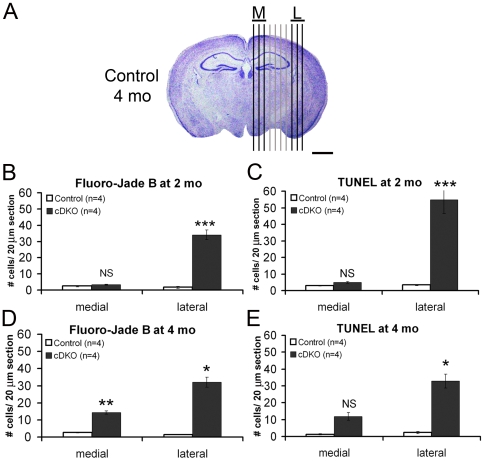
More dramatic increases in apoptosis in the lateral cortex of Psen cDKO mice.Black vertical lines superimposed on an image of a Nissl-stained coronal brain section depict the relative positions of sagittal brain sections spaced 300 µm apart that were analyzed for either Fluoro-Jade B+ or TUNEL+ cells. The average (± s.e.m.) of the three medial-most sections (M) was compared to the average of the three lateral-most sections (L). Scale bar: 1 mm. For each timepoint, 4 mice per genotype (10 sections per mouse) were analyzed. (A, B) Quantification of numbers of Fluoro-Jade B+ cells in sagittal brain sections from mice at 2 months (A) or 4 months (B). At 2 months of age, increases in degenerating neurons are more pronounced in the lateral sections (control: 1.7±0.7; cDKO: 34.1±3.1; p<0.01) than in the medial sections (control: 2.5±0.3; cDKO: 3.4±0.3; p>0.05). By 4 months of age, the number of degenerating neurons increases significantly in medial sections of cDKO mice, compared to controls (control: 2.6±0.3; cDKO: 14.3±1.1; p<0.01). Furthermore, the number of degenerating neurons in lateral sections of cDKO mice is much greater than in medial sections (control: 1.4±0.1 vs. Psen cDKO: 32.1±3.0; p<0.02). *, p<0.05; **, p<0.01; ***, p<0.001. (C, D) Quantification of numbers of TUNEL+ cells in sagittal brain sections from mice age 2 months (C) or 4 months (D). (C) No significant increase was observed in TUNEL+ cells in the Psen cDKO medial cortex at 2 months (control: 3.0±0.3 vs. Psen cDKO: 4.9±0.5; p = 0.05), in contrast to a large increase in lateral Psen cDKO cortex (control: 3.4±0.4 vs. Psen cDKO: 54.8±8.0; p<0.05). (E) At 4 months, lateral Psen cDKO cortex showed a significant increases in TUNEL+ cells (control: 2.3±0.5 vs. Psen cDKO: 32.9±4.1; p<0.05), while medial Psen cDKO cortex showed only a trend toward increased apoptosis (control: 1.3±0.3 vs. Psen cDKO: 11.9±2.3; p = 0.05).